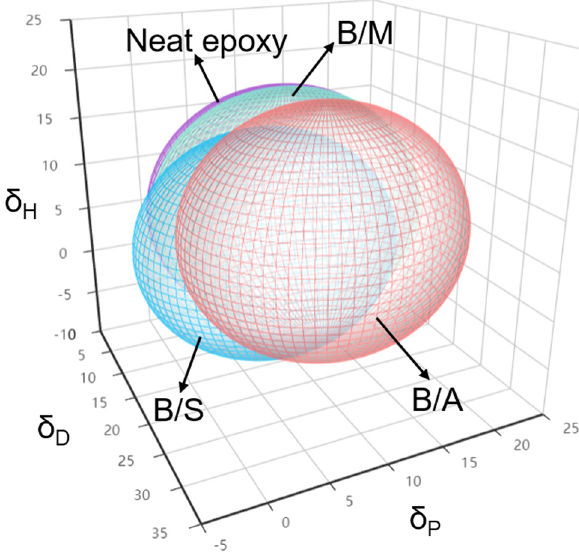
Figure 3: HSP spheres of neat epoxy and core/shell nanoparticles.